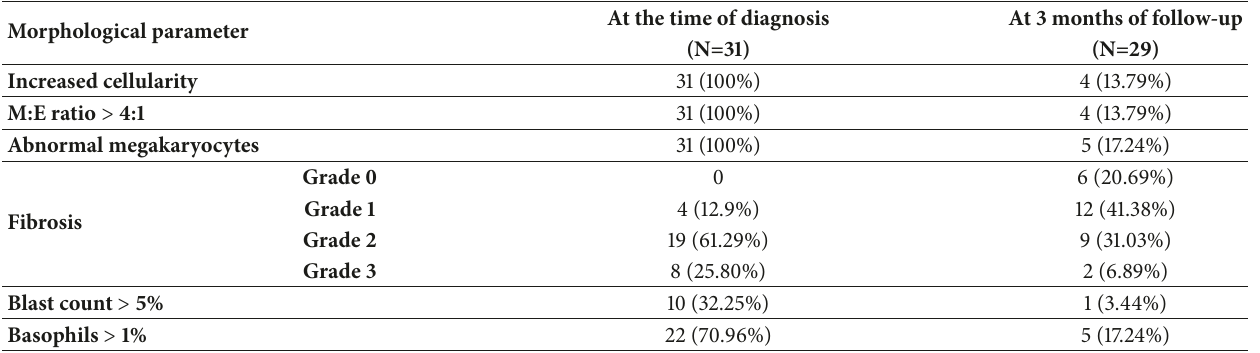
At the time of diagnosis